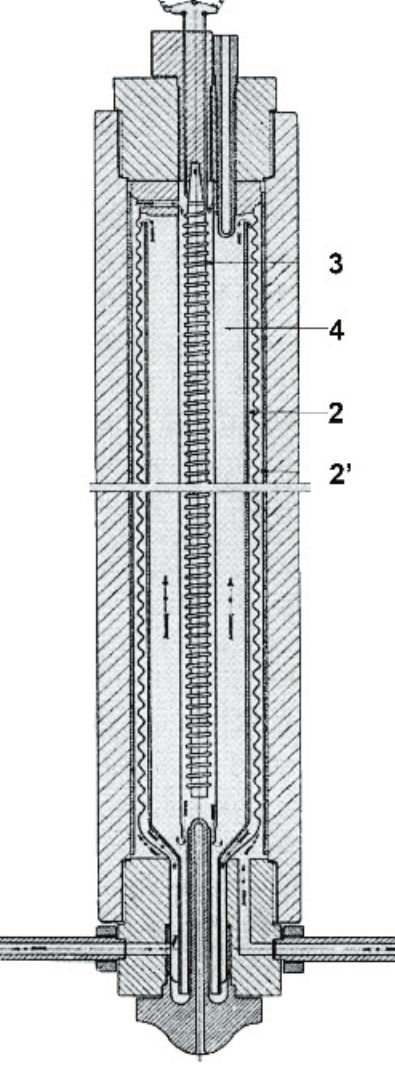
Figure 1. Casale ammonia converter (reactor), 1920s. Key: 1, gas (nitrogen-hydrogen) inlet; 2, 2’, concentric annular spaces, divided by corrugated partition; 3, electrical heater; 4, catalyst space; 5, ammonia and unreacted nitrogen-hydrogen outlet. Redrawn from A. Miolati, Synthetic Ammonia and the Casale Process. Amplified edition of a lecture delivered the 27 th February 1927 at the Institute of Chemistry of the Polytechnic School of Prague (transl. G. Impal- lomeni, 2009). “L’Universale” Tipografia Poliglotta/Ammonia Casale SA, Rome, 1927, p.